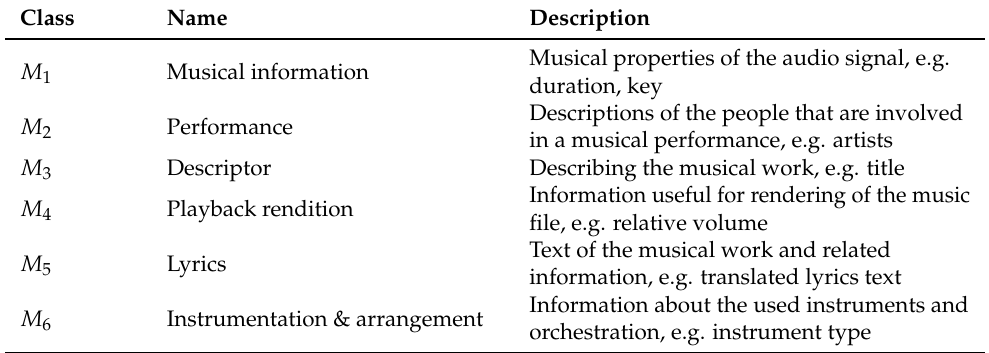
Table 1. Music metadata